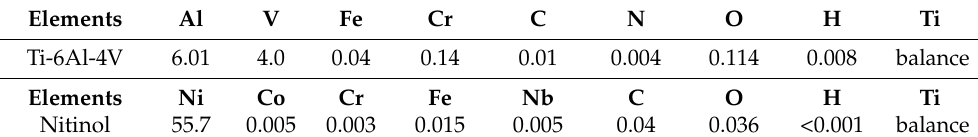
Table 1. Composition of base metals (wt%).